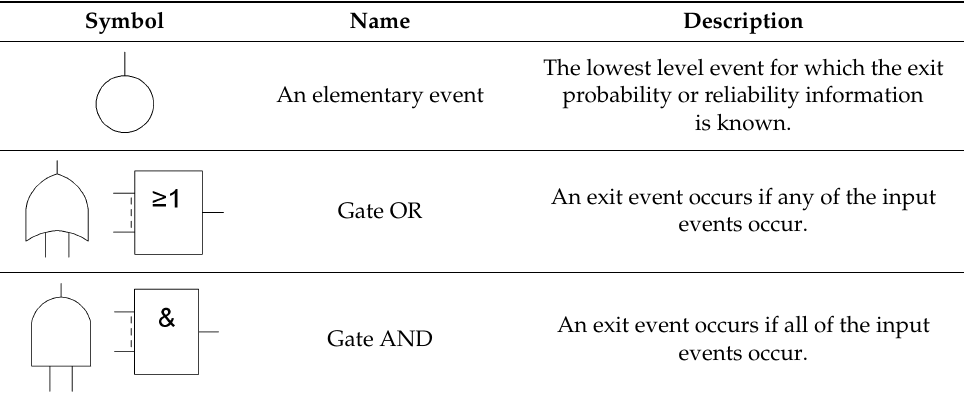
Table 1. Basic symbols used in the FTA method [30].